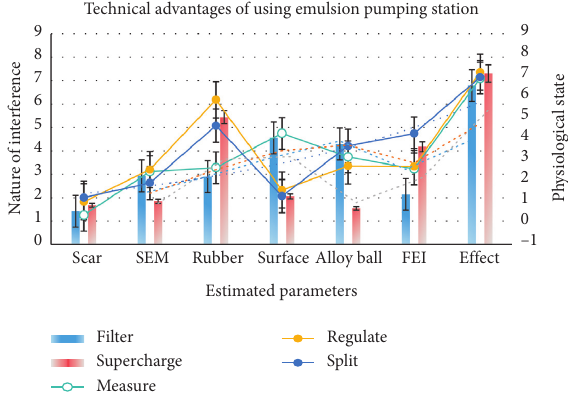
Figure 9: Technical advantages of using the emulsion pumping station.